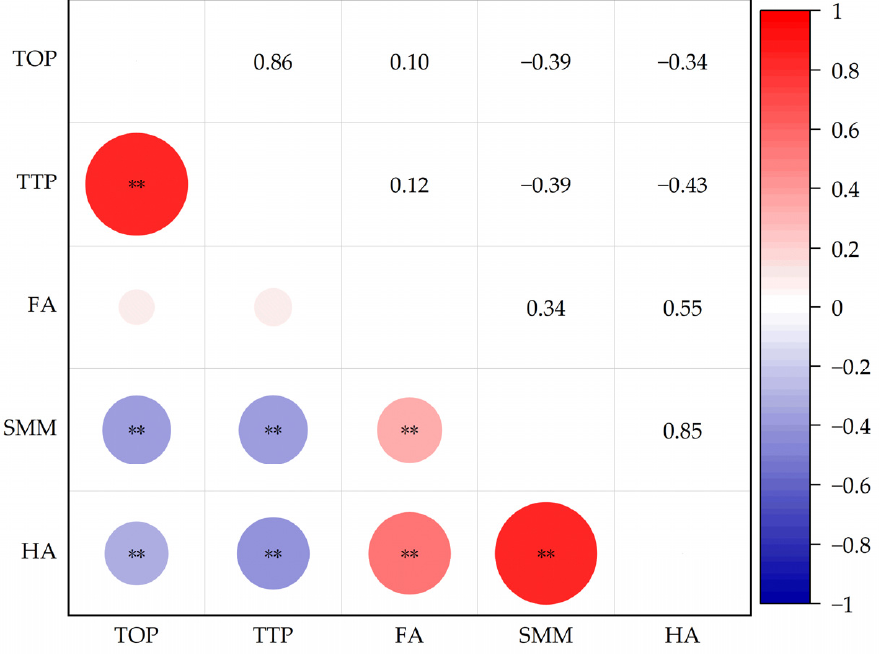
Figure 7. Correlation among soil DOM fluorescence components. Note: TOP means tyrosine-like proteins; TTP means tryptophan-like proteins; FA means fulvic acid; SMM means soluble microbial metabolites; HA means humic acid. The figure shows the correlation between the measured indicators. ** indicate a significant correlation at p < 0.01, respectively. The colors and numbers indicate the degree of correlation between the corresponding row comment and column comment, red is a positive correlation, and blue is a negative correlation.